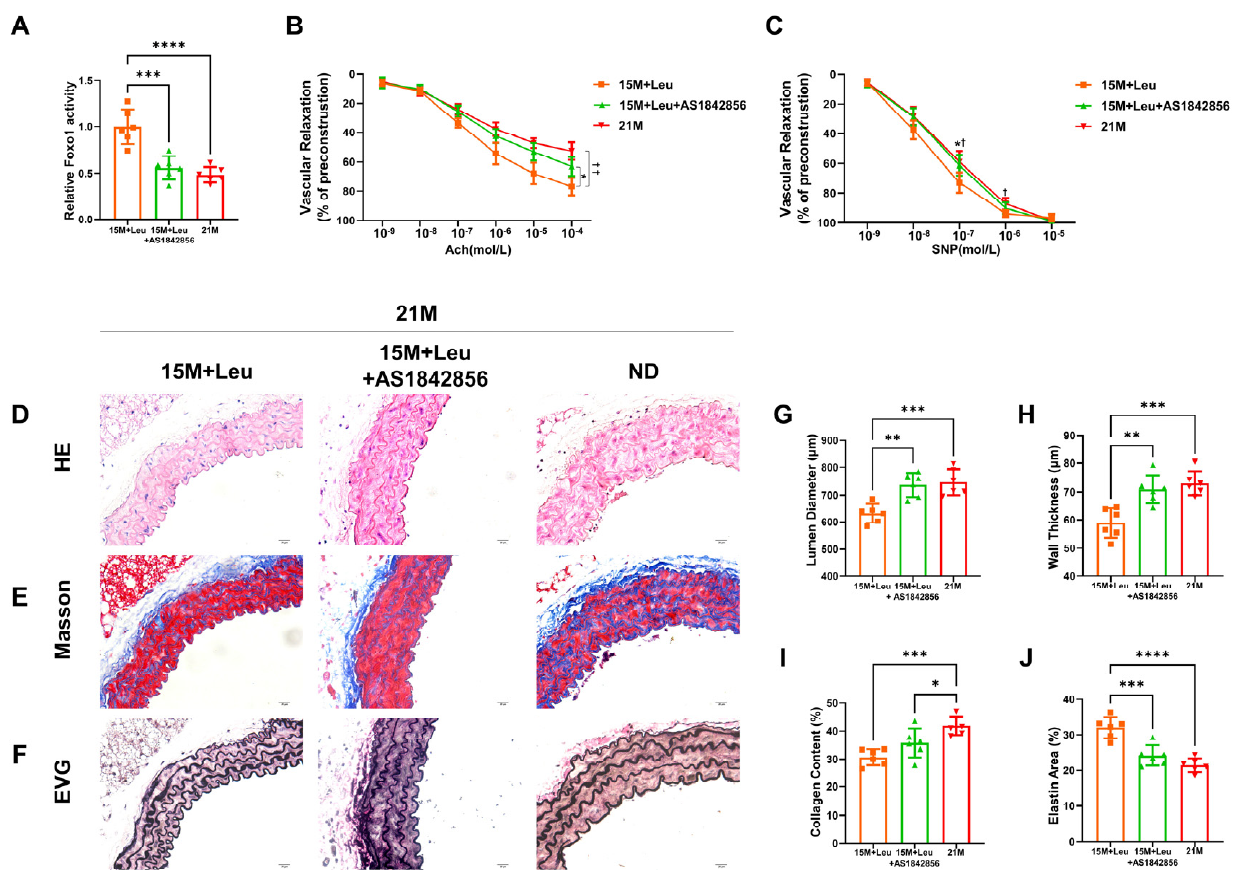
Figure 5. Inhibition of Foxo1 activity reversed the protective effects of leucine supplementation on vascular dysfunction and remodeling . Quantification of Foxo1 activation ( A ). Dose–response curves for acetylcholine-mediated endothelium-dependent relaxation ( B ) and SNP-mediated endothelium-independent relaxation ( C ). Representative images of H&E, Masson’s, and van Gieson’s in aortas from mice at 2M and 21M, and 21M mice with leucine supplementation from 15M, with or without Foxo1 inhibitor AS1842856 ( D – F ). Quantitative analysis is shown in ( G – J ). Statistical analysis of vascular relaxation curves was performed with two-way ANOVA, * p < 0.05 15M + Leu + AS1842856 vs. 2M group, † p < 0.05 21M vs. 2M group, †† p < 0.01 21M vs. 2M group. Histological statistical analysis was performed with one-way ANOVA, * p < 0.05, ** p < 0.01, *** p < 0.001, and **** p < 0.0001. All data are presented as mean ± SEM, n = 6/group. ND: normal diet.